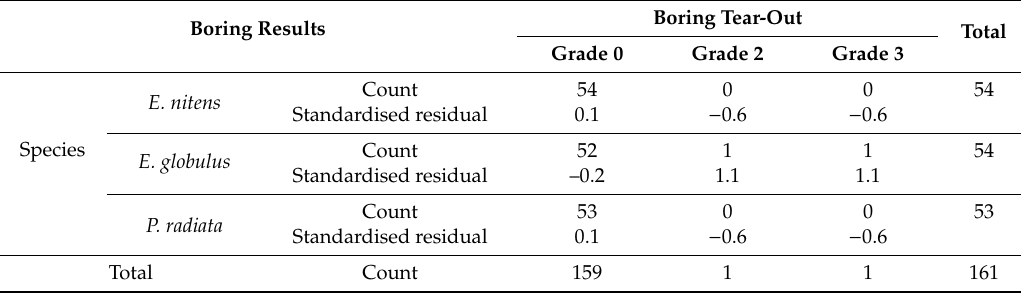
Table 5. Grading results according to boring.